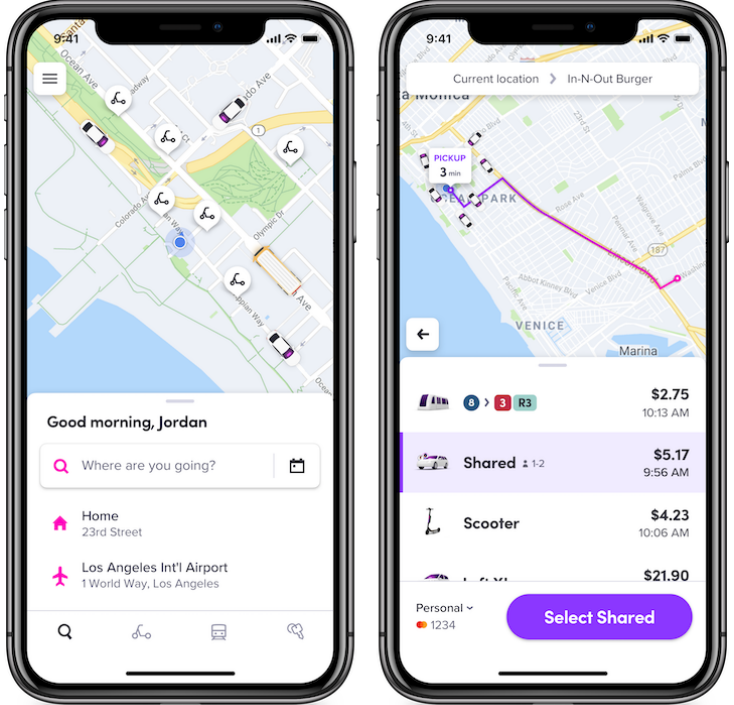
Figure 1. Screenshots from the user interface while booking a trip in the Lyft app. Source: Lyft